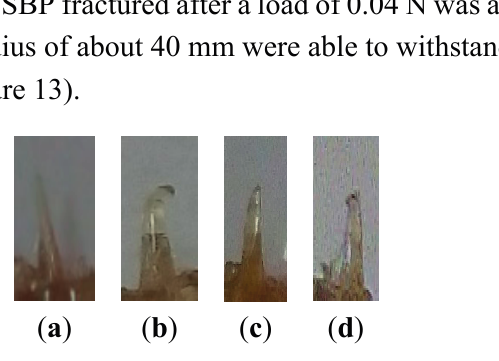
Figure 13. NC 0 ( a ) before fracture and ( b ) after fracture after 0.04 N, ( c ) NC 20 before fracture and ( d ) fractured after 0.5